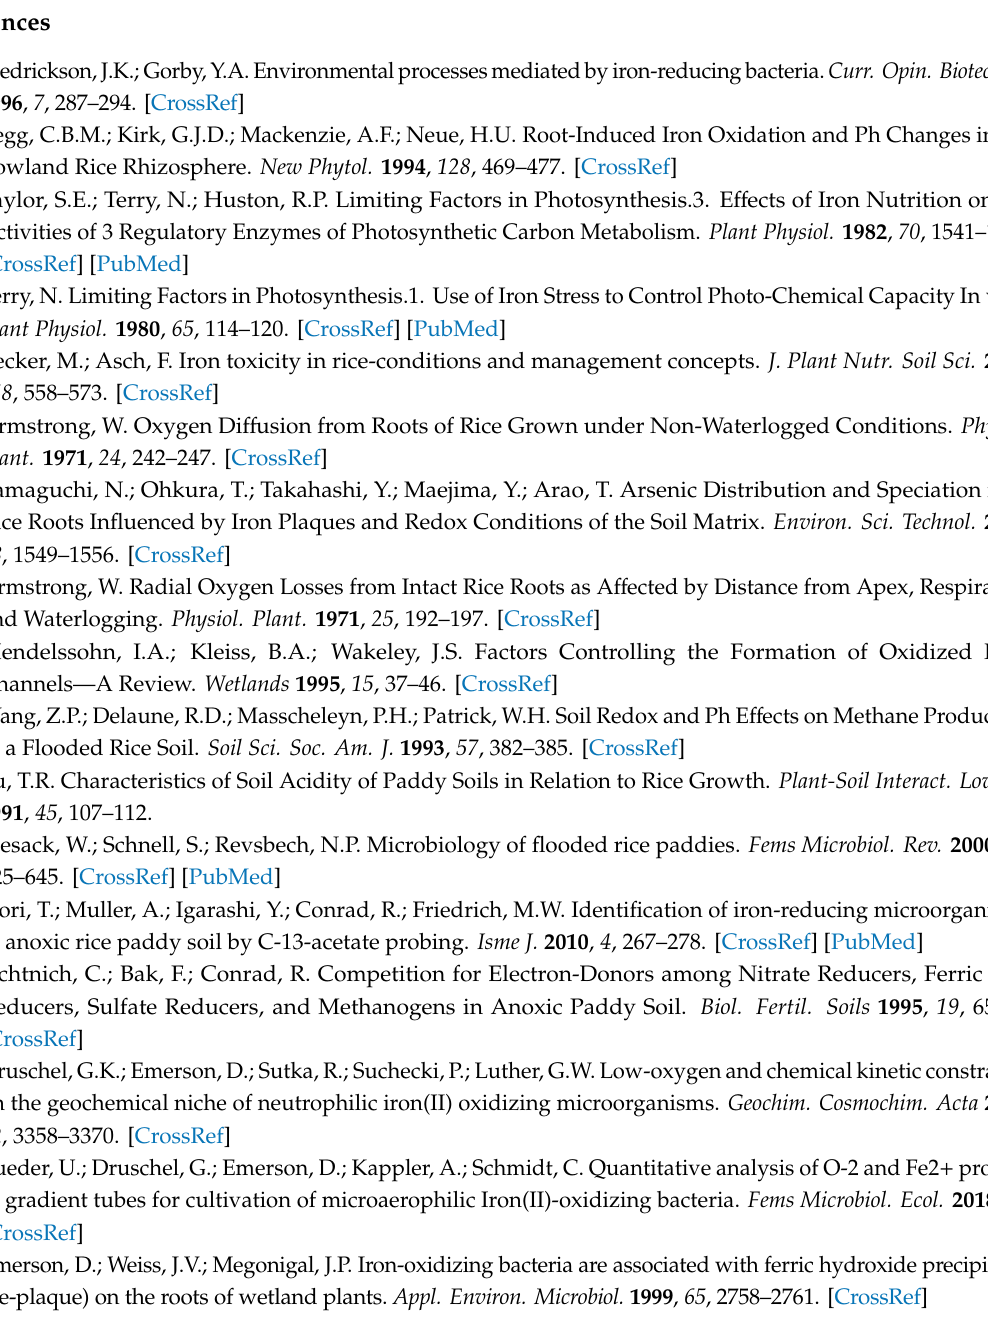
77 K. Table S3: Mössbauer spectra hyperfine parameters for non / reduced root iron plaque minerals; Figure S4: Mössbauer spectra of root iron plaque reduction experiments in rhizotron measured at 77